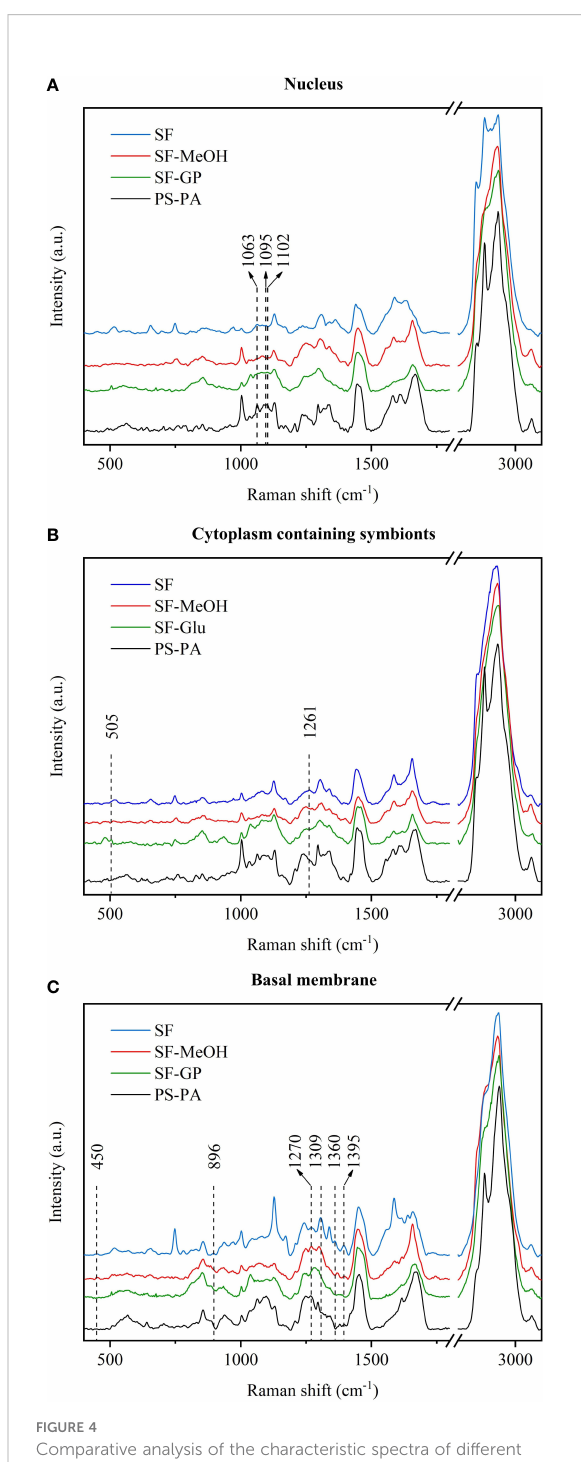
FIGURE 4 Comparative analysis of the characteristic spectra of different regions of the samples subjected to the four different preservation methods. (A) Nucleus. (B) Cytoplasm containing symbionts. (C) Basal